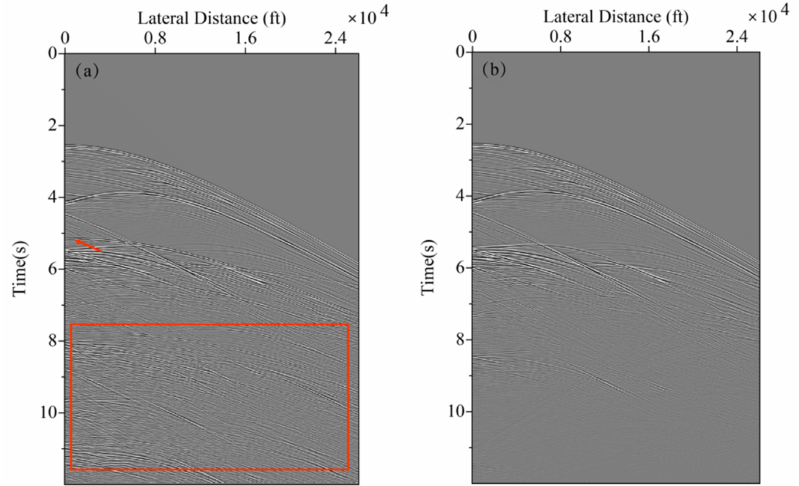
Figure 5. Partial training data set pairs. ( a ) Input shot record with primaries and surface-related multiples. ( b ) Input shot data without surface-related multiples.